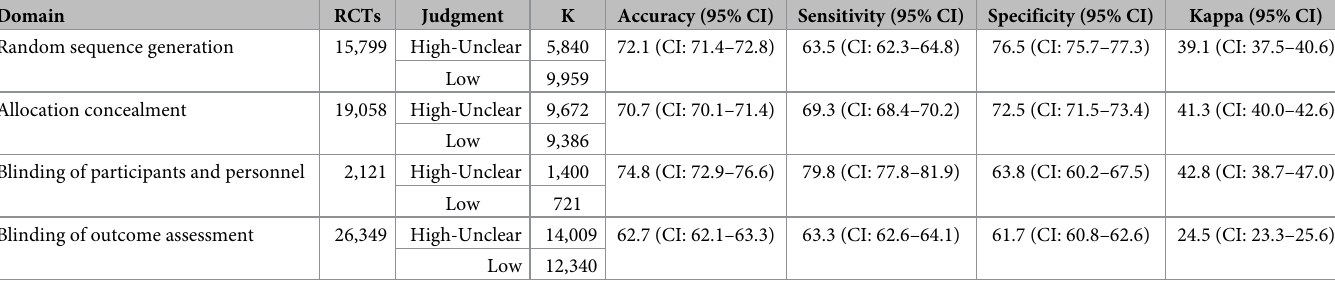
Table 1. Validation of the 4 risk-of-bias domains between automated and human assessments in RCTs obtained from the Cochrane systematic reviews risk-of-bias tables. Domain RCTs Random sequence generation Allocation